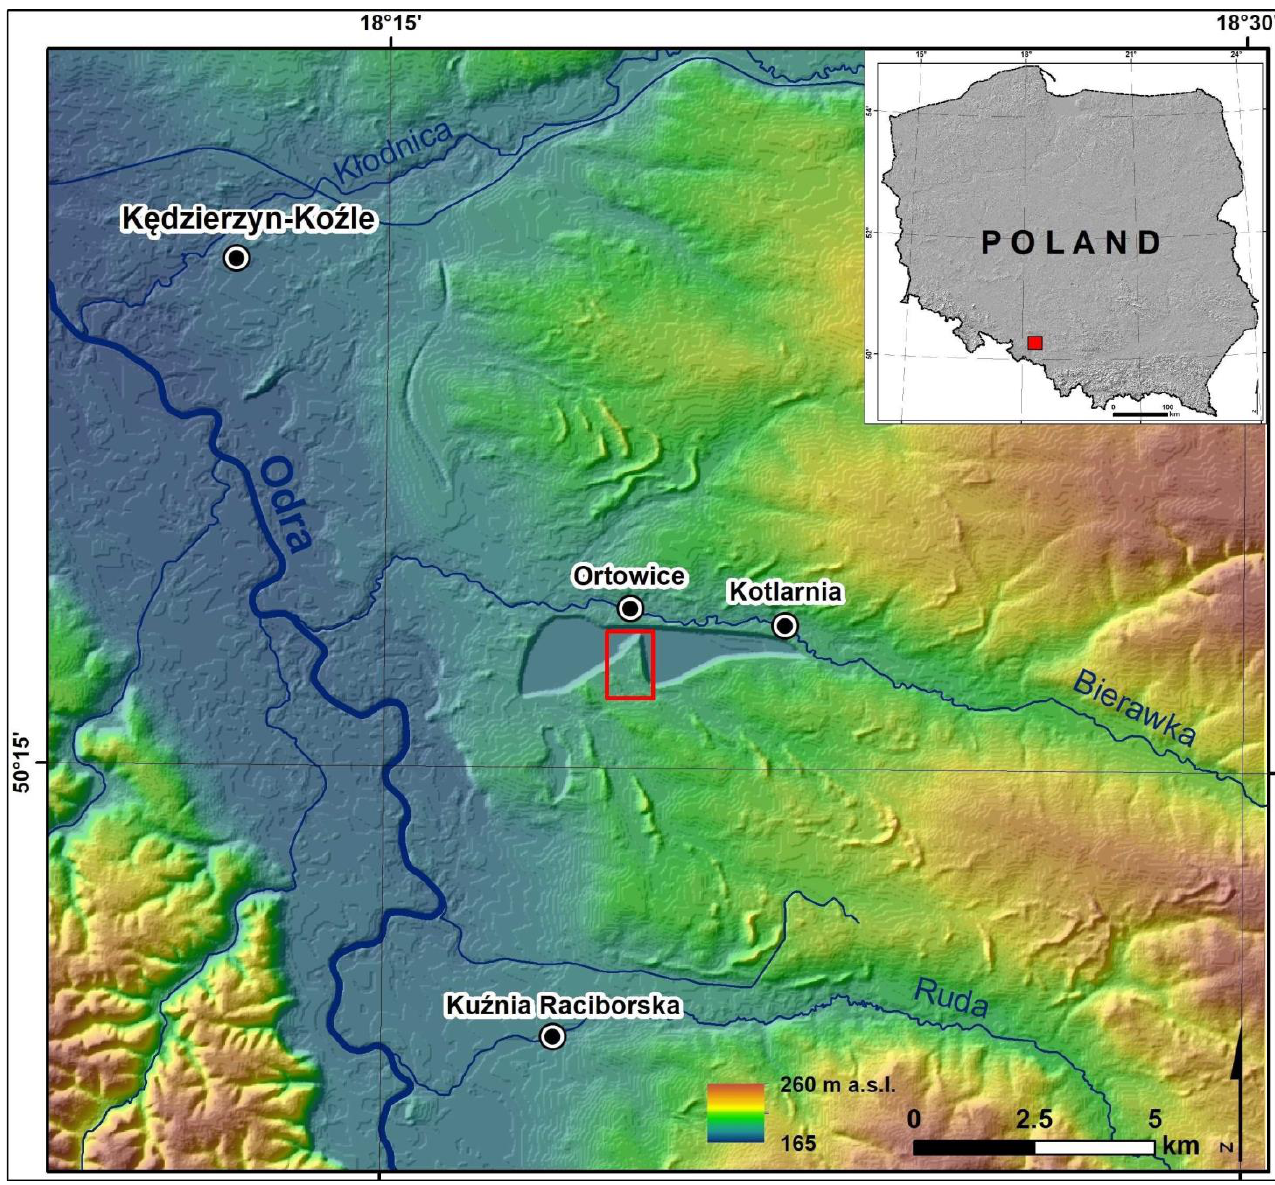
Figure 1. Location of the study area.